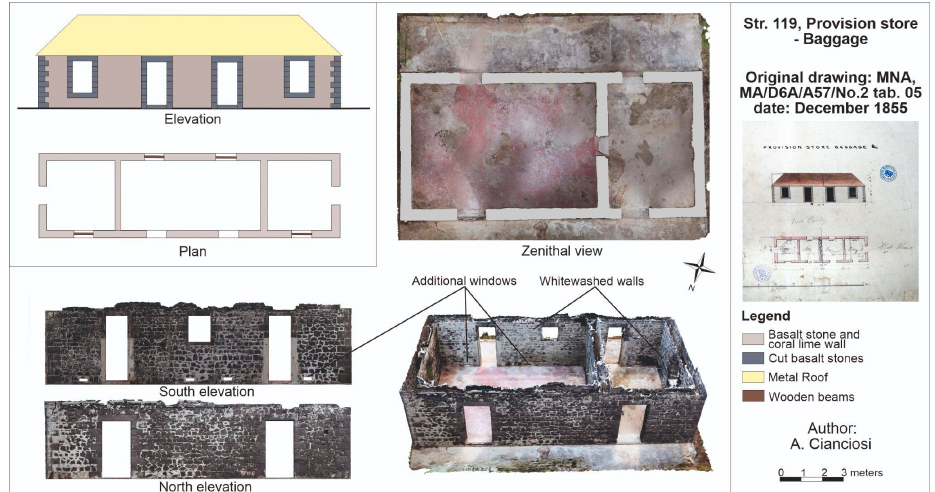
Figure 12. The baggage store: redrawn plan from the archival document (top left) in comparison with photogrammetric orthomosaic image.